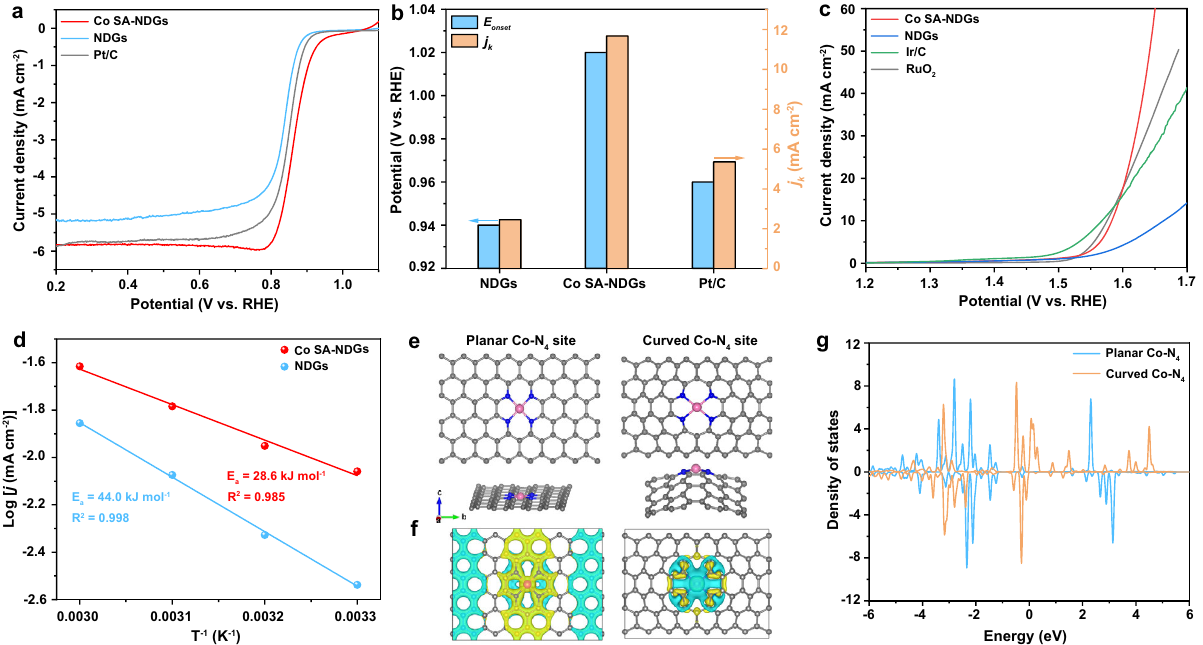
Fig. 2 Electrocatalytic O2 performance and DFT calculations of Co SA-NDGs. a LSV curves of Co SA-NDGs, NDGs and Pt/C catalysts for ORR. b Comparison of E onset and j k at 0.85 V (V vs. RHE). c LSV curves of Co SA-NDGs, NDGs, Ir/C and RuO 2 for OER. d Arrhenius plots of Co SA-NDGs and NDGs at the overpotential of 350 mV. e Established models of planar Co-N 4 site and curved Co-N 4 site. f Calculated differential charge density. Yellow and cyan areas represent charge density aggregation and depletion, respectively. g Density of states for planar Co-N 4 site and curved Co-N 4